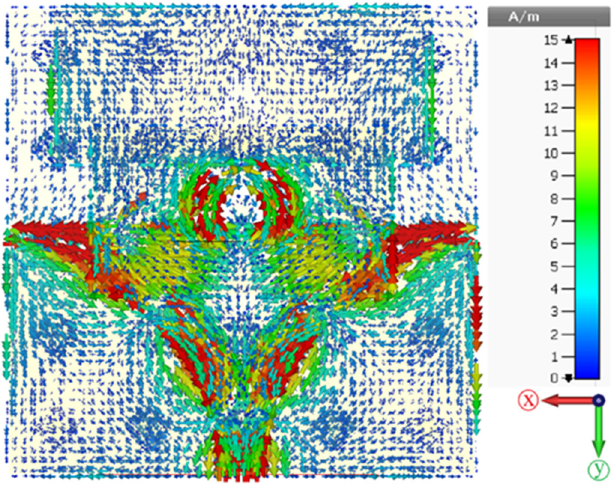
Figure 20. Surface current distribution at 8.6 GHz.